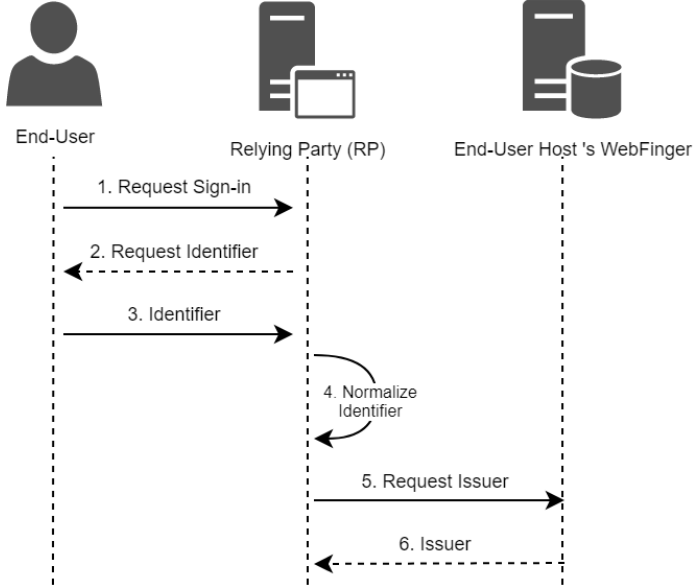
Figure 1. OIDC Dynamic Discovery